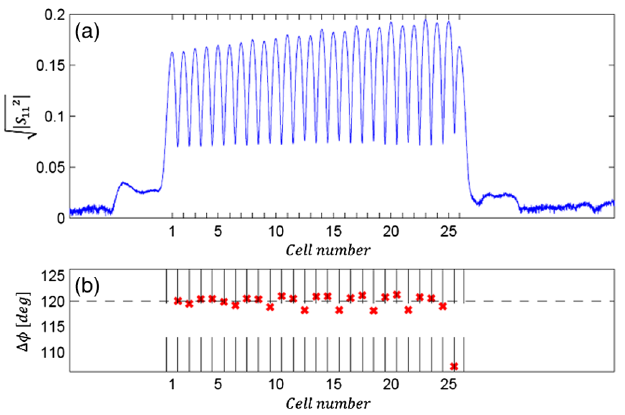
FIG. 2. Bead-pull measurement results after tuning the proto- type at 11.424 GHz. (a) Electric field distribution along the beam axis ( S 11 is the reflection coefficient at the input port) and (b) phase advance per cell